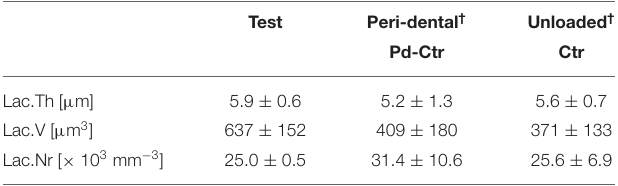
TABLE 2B | Three-dimensional morphometric investigation of the osteocyte lacunar network in the test-maxilla (Test) retrieved after 7 years in-vivo : comparison with peri-dental bone (Pd-Ctr) and with unloaded bone